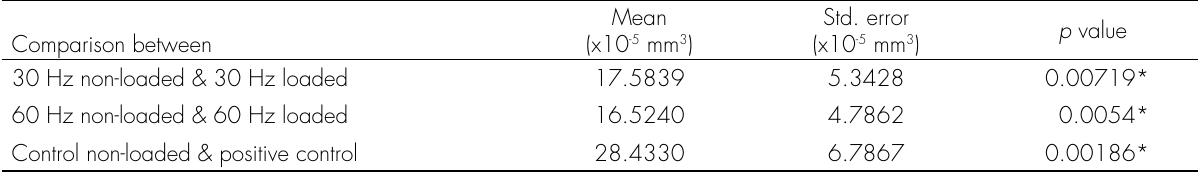
Table I. Paired t -test comparing the volume of root resorption crater between non-loaded and unloaded molars in each vibration group.